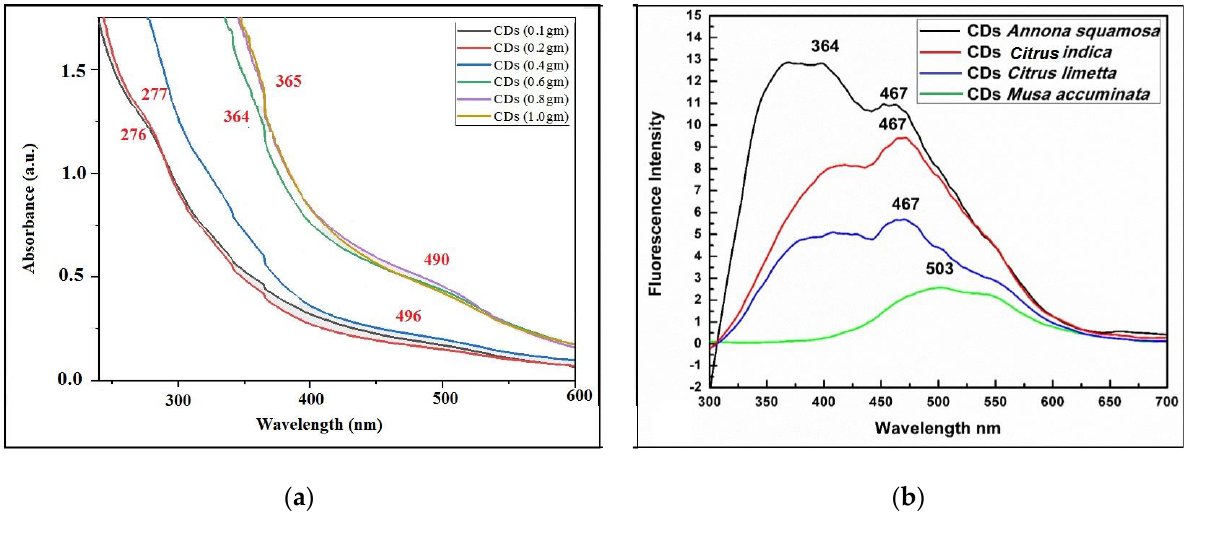
Figure 2. ( a ) UV – Vis spectrum of Annona squamosa- mediated CDs synthesized at various concen- trations; ( b ) photoelectric luminance analysis (excitation wavelength 364 nm).